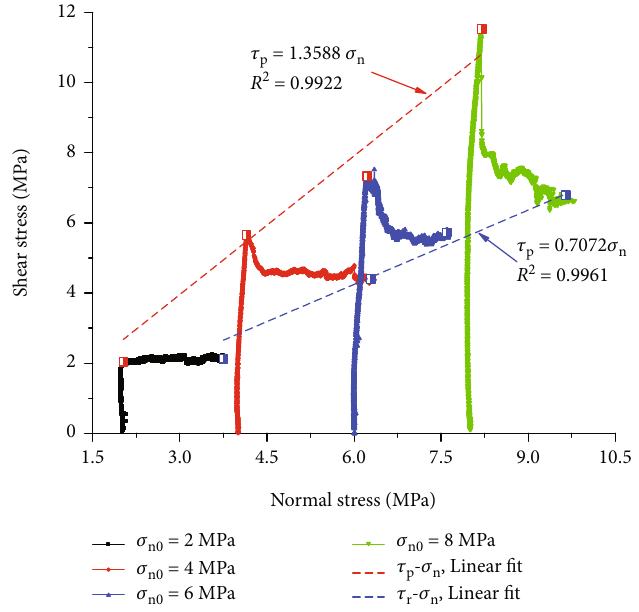
Figure 6: Path evolution curves of shear stress with normal stress